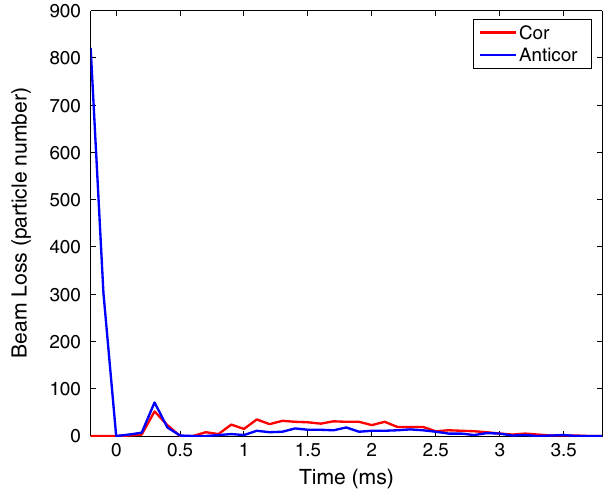
FIG. 9. Comparison of the beam loss during the 200 turns injection and 2000 turns acceleration processes for the two painting methods in the simulation under the same